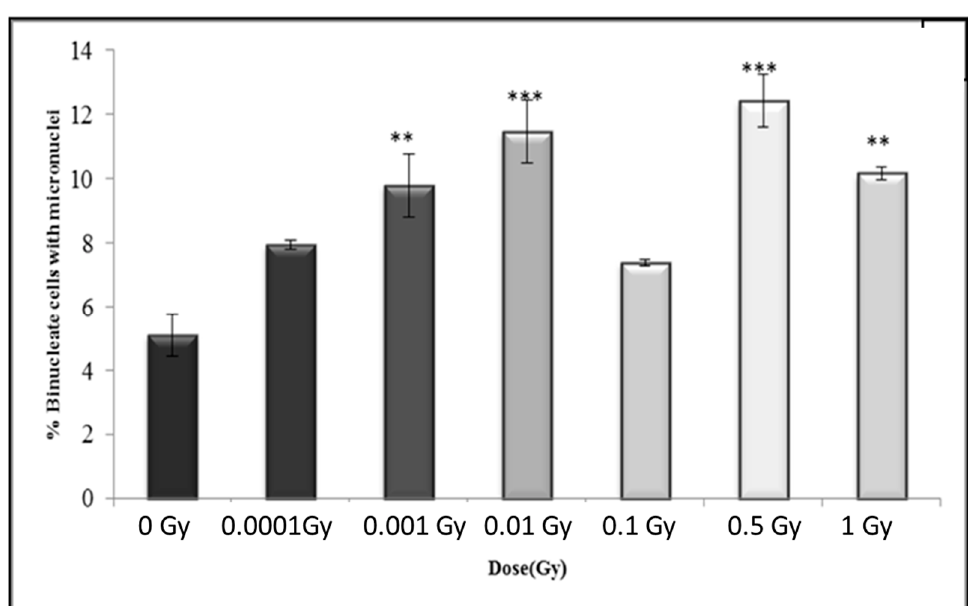
Figure 12. Percentage of binucleate cells containing micronuclei over total binucleate cells in control and irradiated HF19 cells at 20 population doublings following irradiation. The figure shows delayed analysis of the variation in the percentage of binucleate cells containing micronuclei as a function of dose for 1000 cells from two parallel but separate experiments. Error bars represent the standard error of the mean of replicate experiments ( ± S.E.M.). p -values were calculated using Fisher’s exact test. ** p ≤ 0.01, *** p ≤ 0.001.